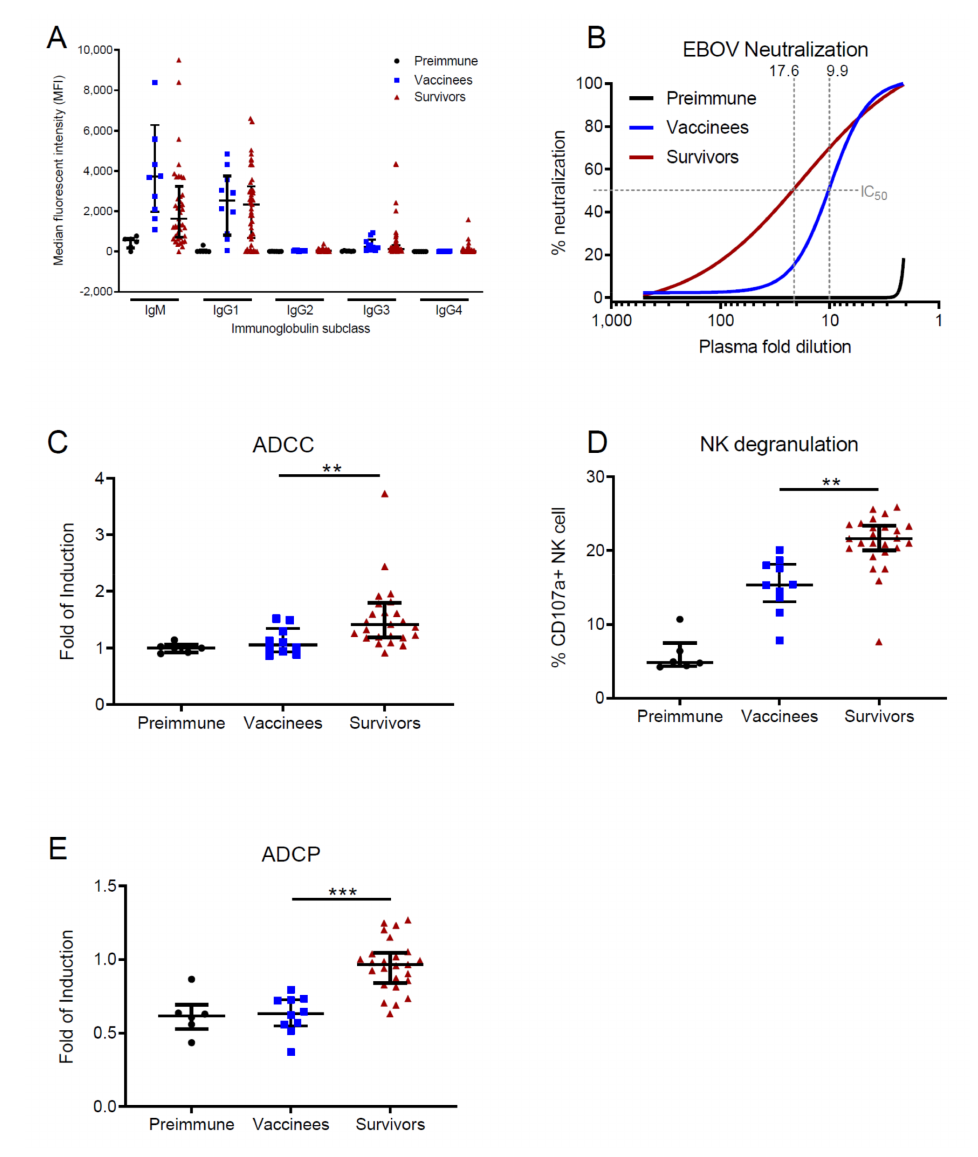
Figure 1. Antibody quantity and functions in recombinant vesicular stomatitis virus vectored vaccine (rVSV-ZEBOV) vaccinees and Ebola virus disease (EVD) survivors. Plasma samples of individuals vaccinated with 2 × 10 7 PFUs of candidate vaccine rVSV ZEBOV 180 days after vaccination (vaccinees, n = 10, blue squares) were compared with plasma from EVD survivors (survivors, n = 25, red triangles). Median Ig levels of vaccinees before vaccination (preimmune, n = 6, black points) served as a control. Points show the individual measurements. Bars show the median as well as first and third quartile of the sample distribution. ( A ) Beads based ELISA for analysis of immunoglobulin (Ig) isotypes and subclasses. Shown is the Median Fluorescent Intensity (MFI) of the secondary antibody in logarithmic scale. ( B ) Plaque reduction (neutralization) assay using authentic EBOV (Mayinga variant). Lines indicate the nonlinear regression. IC 50 values are indicated by light grey pointed lines. ( C ) Antibody-dependent cellular cytotoxicity (ADCC) reporter assay. ( D ) Natural killer (NK) cell degranulation assay. ( E ) Antibody-dependent cellular phagocytosis (ADCP) reporter assay. In all graphs, significance is indicated in lines. Significance levels are calculated using Mann–Whitney tests and indicated by asterisks, namely ** p ≤ 0.01; *** p ≤ 0.001. IC 50 : half maximal inhibitory